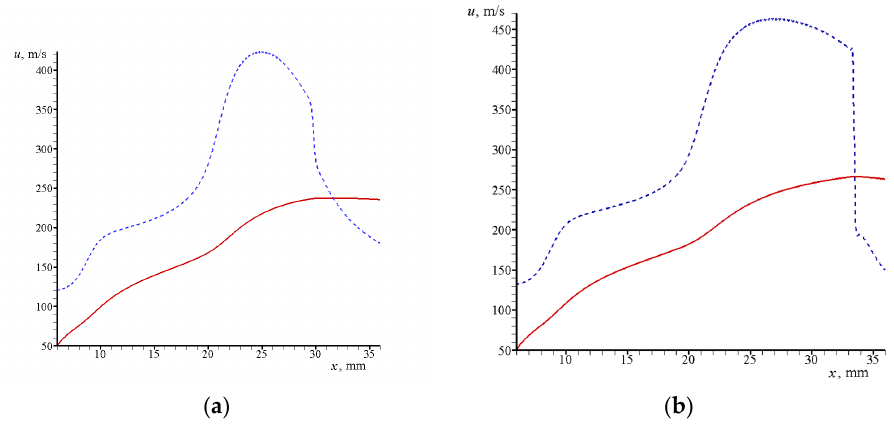
Figure 11. Calculated gas velocities u = u ( x ) (dashed lines) and particle velocities u p = u p ( x ) (solid lines) at h = 0.2 mm ( a ) and h = 0.4 mm ( b ).